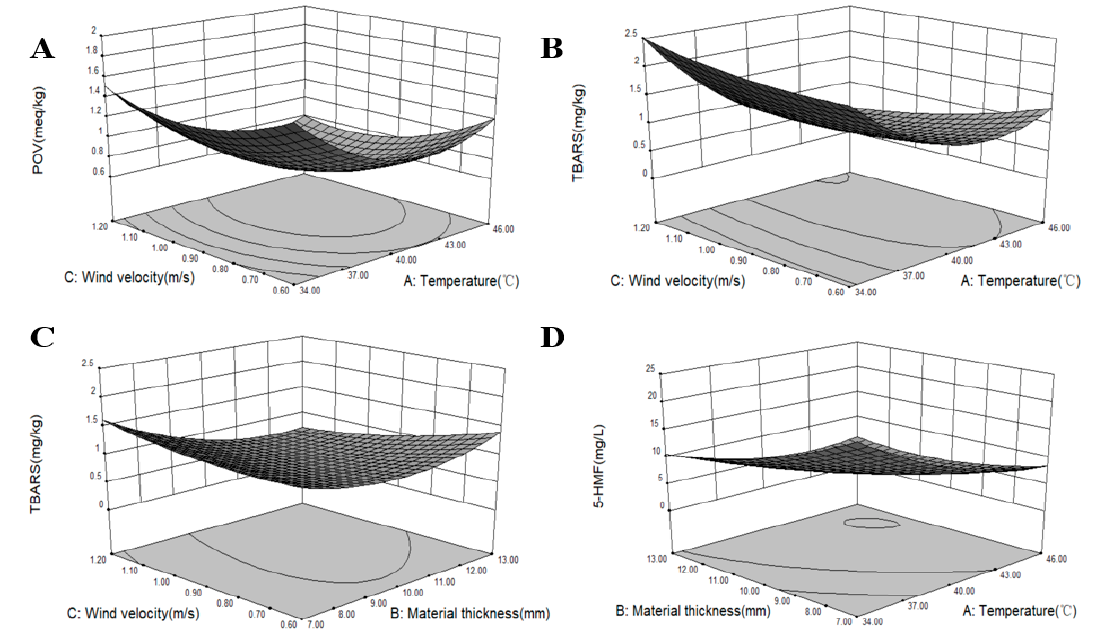
Figure 3. The effects of three optimization conditions on the POV, TBARS values, and 5-HMF contents. ( A ) The interactive effect of temperature and wind velocity on the POV. ( B ) The interactive effect of temperature and wind velocity on the TBARS values. ( C ) The interactive effect of wind velocity and material thickness on the TBARS values. ( D ) The interactive effect of temperature and material thickness on the 5-HMF contents.